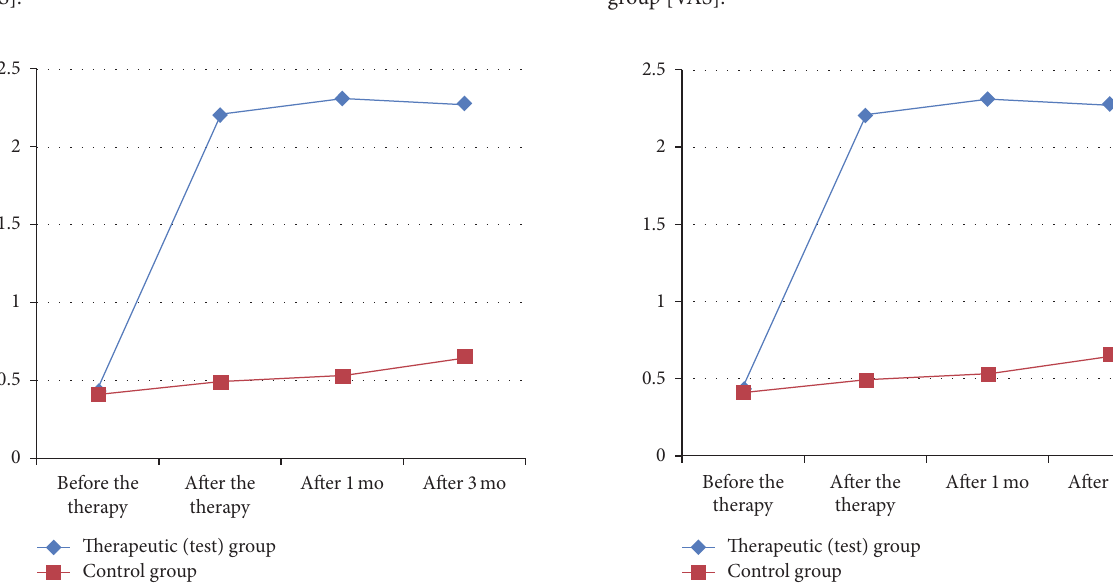
Figure 1: Dynamics of pain at rest in the test and control group [VAS].